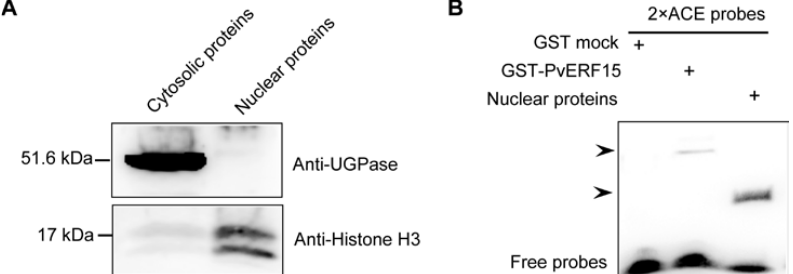
Figure 2. ACE specifically binds to the nuclear proteins in vitro. ( A ) Western blot verified the anti-glucose pyrophosphorylase (UGPase) (cytoplasm marker) antibody. ( B ) EMSA was performed usingbiotin-labeled2 × ACEprobeswiththea ffi nity-purifiedGST-PvERF15(positivecontrol), GSTmock (negative control), and nuclear proteins from the etiolated Arabidopsis seedlings. The bound complex is indicated by the arrows. The experiments were performed two times showing similar